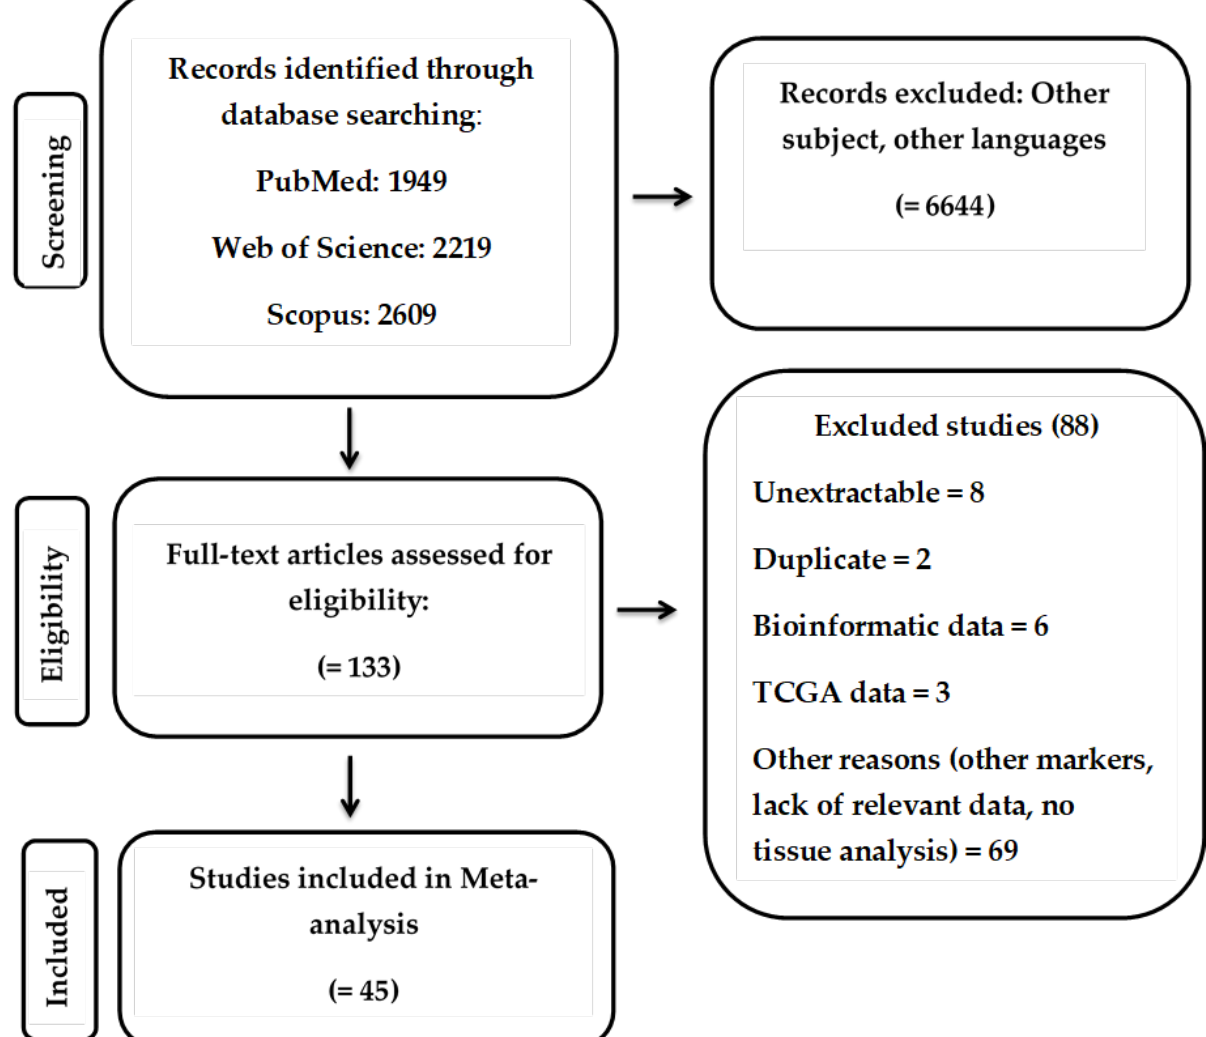
Figure 2. Flow chart summarizing the literature search and study selection.